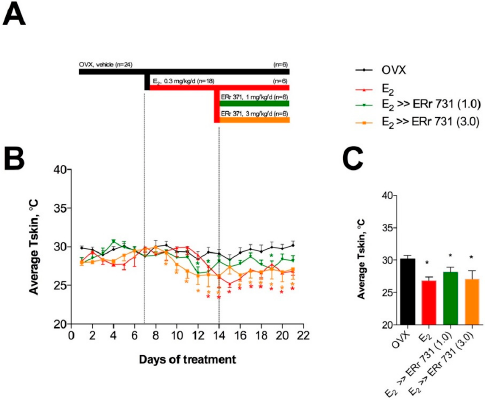
Figure 5. Time course of E 2 supplementation and ERr 731 replacement therapy in OVX rats. ( A ) Schematic diagram of the replacement strategy. ( B ) In the dark phase, the E 2 treatment of OVX rats significantly reduced T skin from experimental day 10 (day 2 of E 2 treatment) through the end of the study. In rats that received ERr 731 therapy, the effect remained significant at high doses (3 mg/kg/day) and reached significance on several days at middle dose (1 mg/kg/day) through the end of the study. ( C ) Overall average T skin was significantly increased in OVX rats and reduced following either E 2 (0.3 mg/kg/day) or ERr 731 replacement therapy (1–3 mg/kg/day) for the duration of the treatment. Data are the mean ± SEM ( n = 6), * p < 0.05 vs. OVX control.